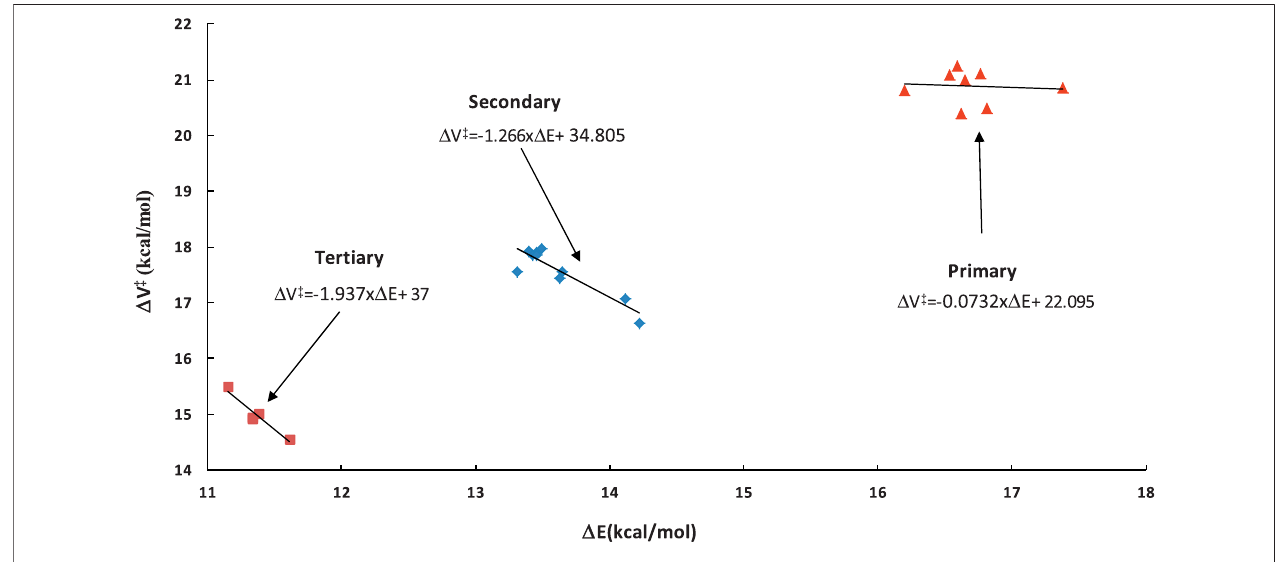
FIGURE 5 | Linear energy relationship (LER) of the barrier heights Δ V versus reaction energies Δ E for the representative set. All data were obtained at the M06-2X/ aug-cc-pVTZ level of theory.